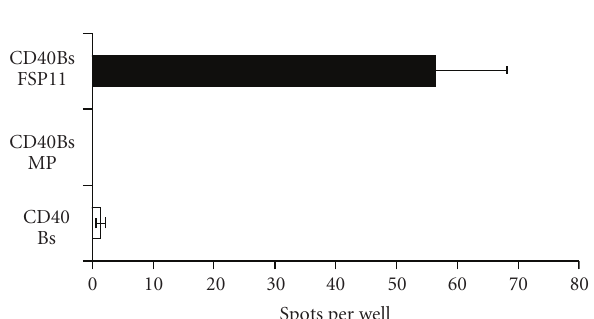
Figure 1: ELISpot analysis. The percentage of T cells secreting IFN- γ in response to FSP11-loaded target cells was determined in a series of ELISpot experiments. An exemplary sample is shown. Reactivity against unloaded, irrelevant MP-peptide-loaded and FSP11-loaded CD40 Bs is displayed. Analysis was performed in triplicates with 1000 e ff ector cells per well.